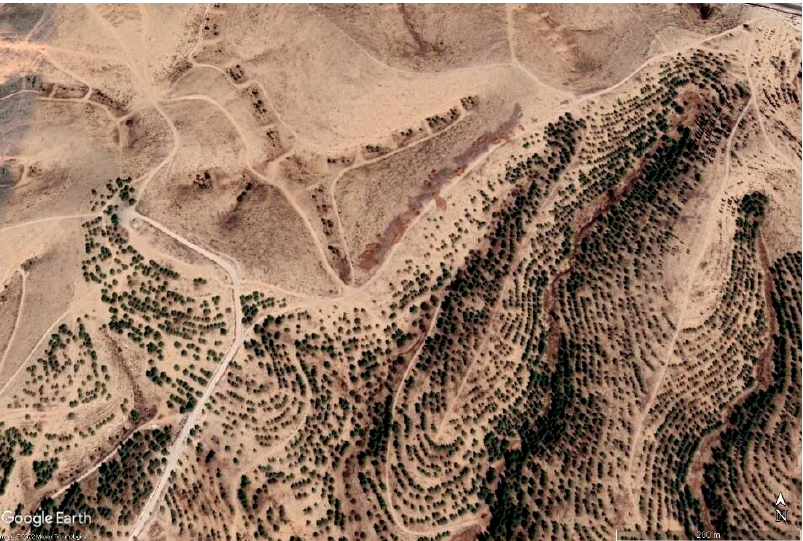
Figure 6. Functional rehabilitation of a desertified system. The upper part—desertified area; The lower part—restored area with planted trees. (Source: Google Earth, (2021) Israel Negev 31°17 ′ 53.24 ″ N, 34°48 ′ 36.58 ″ E, elevation 373M, 3D layer, Image date: 10 August 2021).